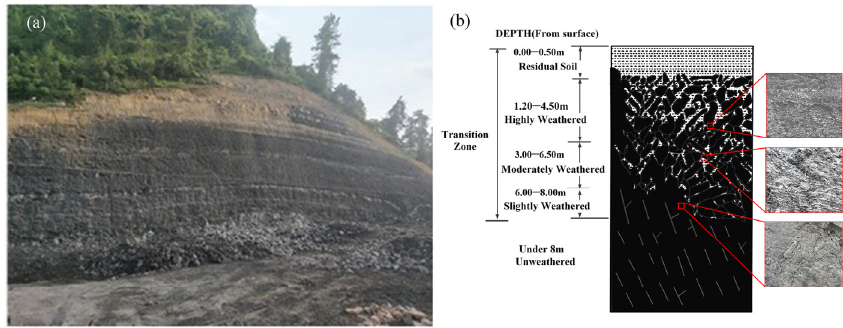
Figure 1. Weathering of carbonaceous mudstone: ( a ) photo; ( b ) schematic diagram.